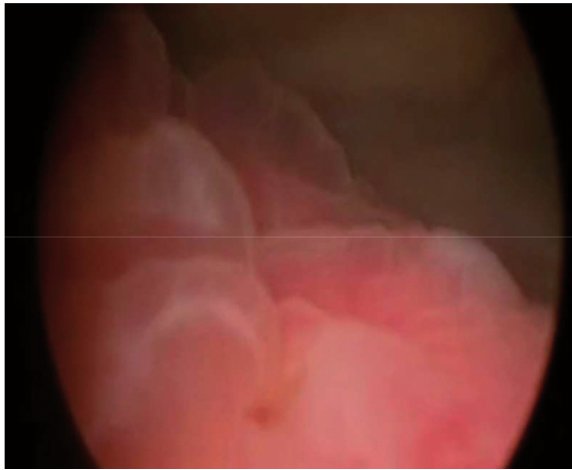
figure 2 - High hyperemic, bullous lesion with size and location similar to those described on ultrasonography.